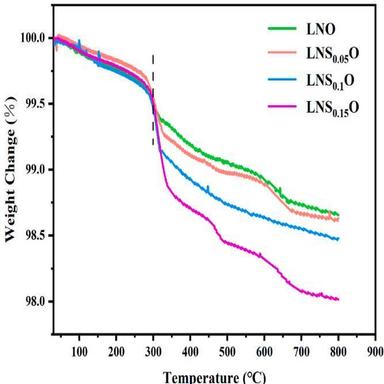
TG curves of La2Ni1-xScxO4+δ (x = 0, 0.05, 0.10 and 0.15) cathode materials.